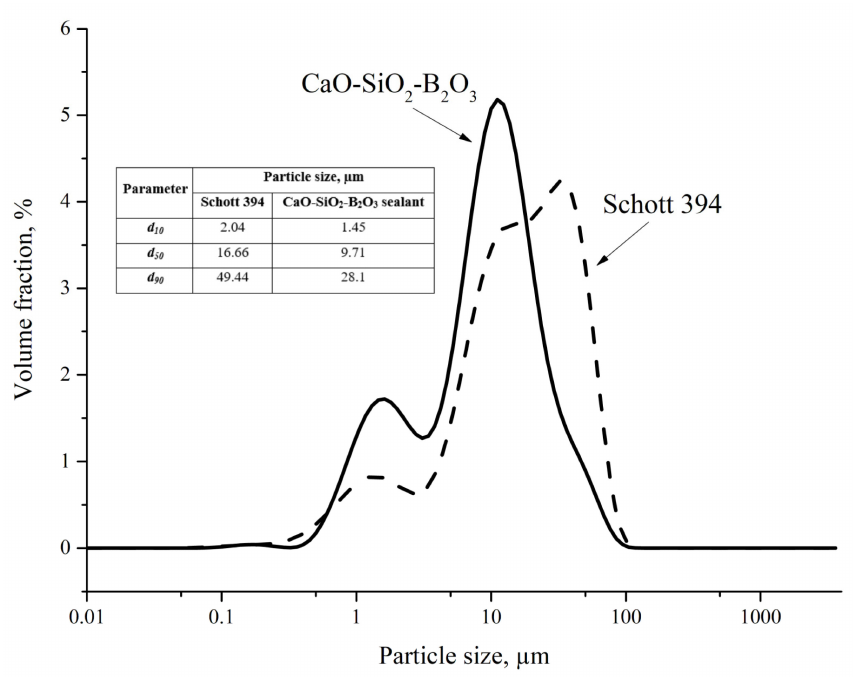
Figure 1. Particle size distribution in a ground powder of CaO-SiO 2 -B 2 O 3 sealant and in commercial Schott powder.